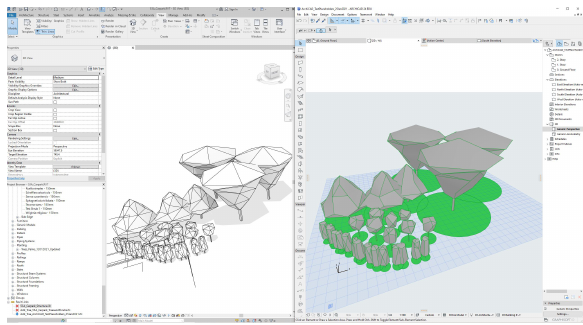
Figure 19. Both Autodesk Revit 2021 (left) and ArchiCAD 24 (right) have been tested for the workflow.